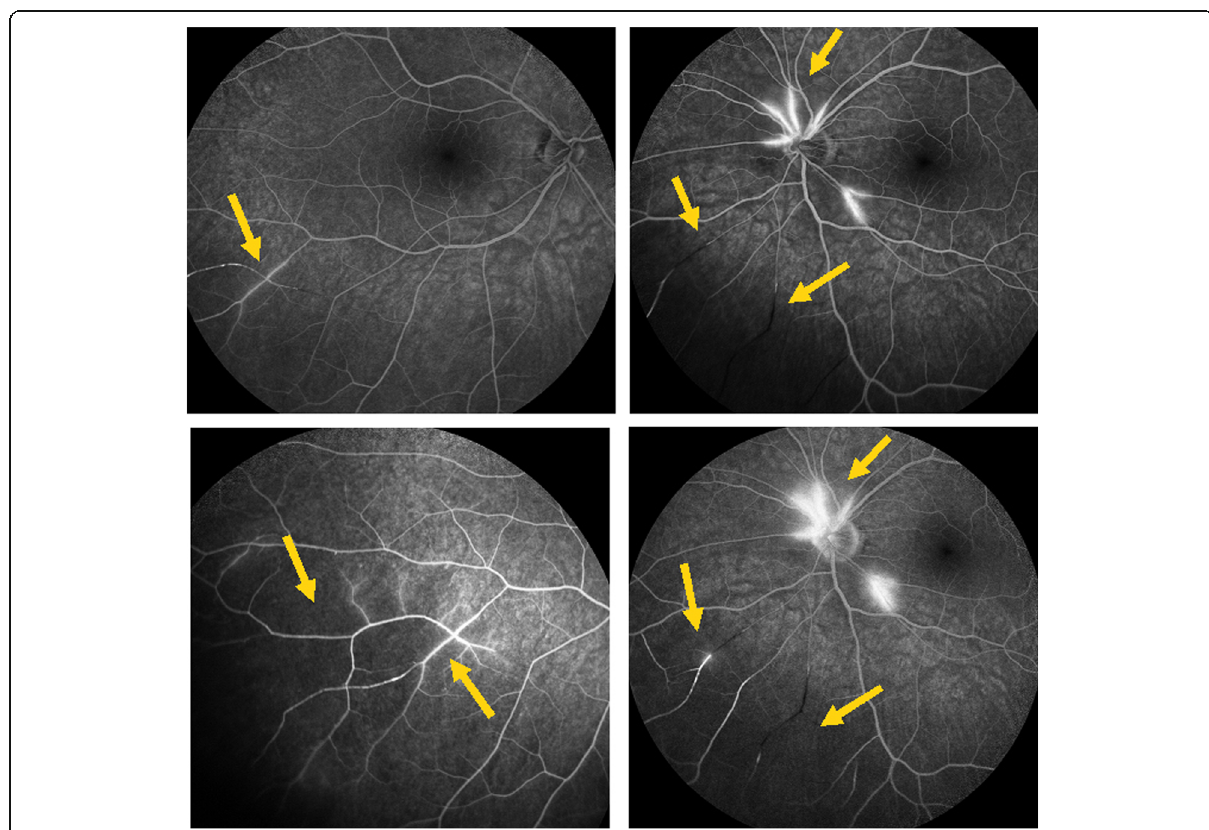
Fig. 7 Fluorescein angiography (FA) showing segmental artery occlusion and hyperfluorescence of the arterial walls in the left eye (two right pictures) in early (top) and late (bottom) angiographic phases. In the right eye (two left pictures) an area of non-perfusion (capillary drop) of vessels in the mid-periphery (top) with staining of arteries better seen in the late phase (bottom). (Case